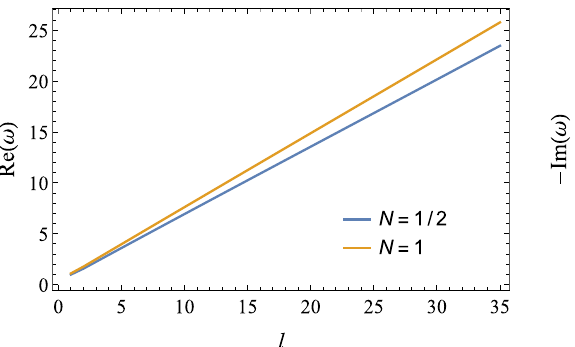
tively; the right diagram represents the negative imaginary parts of ω with respect to l for the cases of N = 1 / 2 and N = 1,